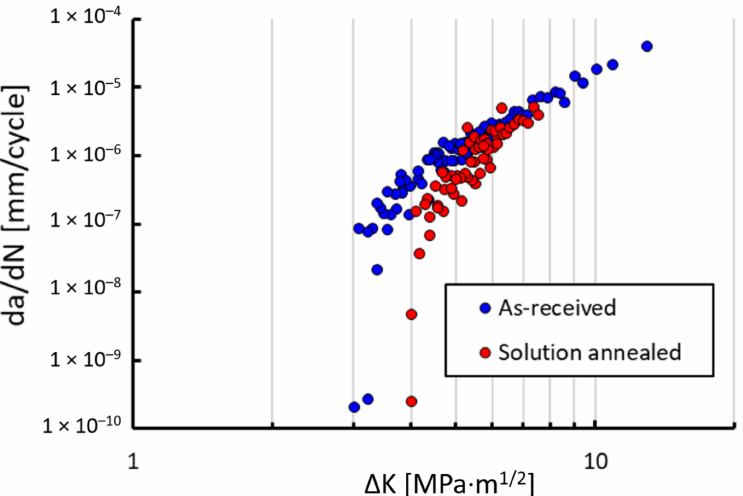
Figure 6. Measured crack growth rates da/dN at the load ratio R = 0.7 for the two microstructural states at room